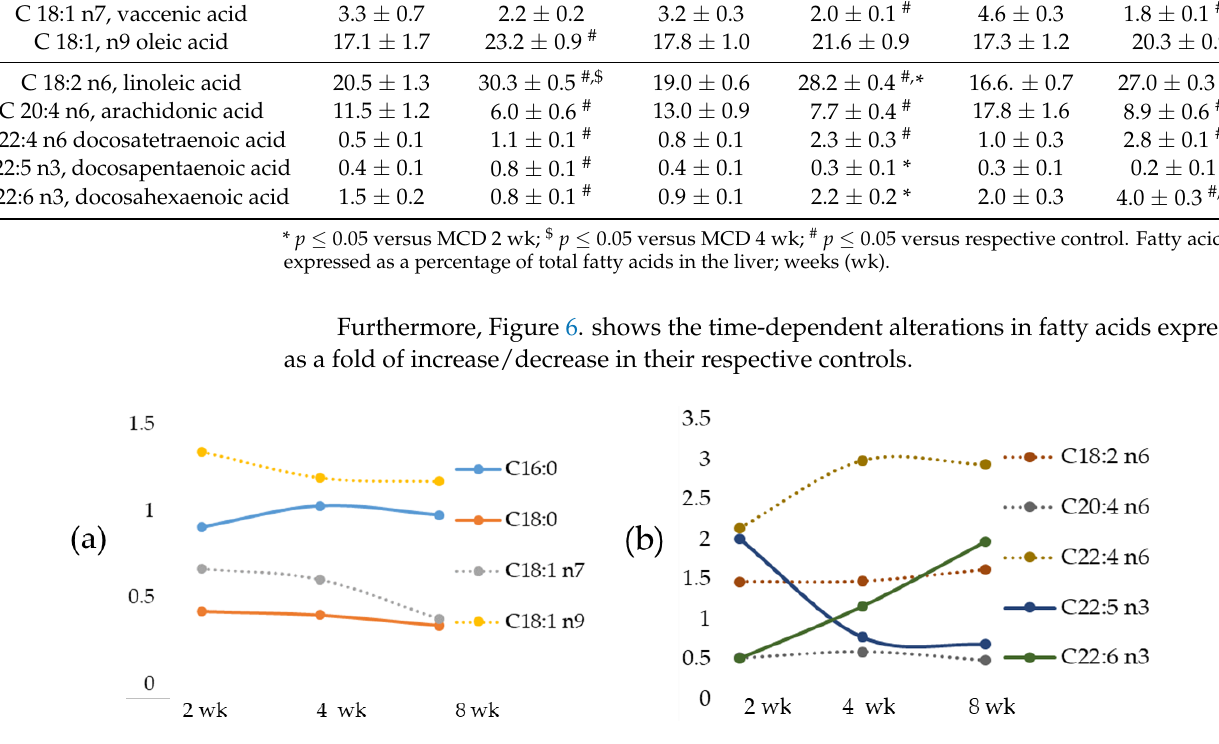
Figure 6. Time-dependent changes in liver fatty acids expressed as a fold increase/decrease in their respective controls. Tissue SFA and MUFA, panel ( a ); tissue PUFA panel ( b ). Weeks (wk). In MCD rats, a positive correlation was found comparing liver Zn versus stearic acid, vaccenic acid, arachidonic acid and docosapentaenoic acid (Table 8); on the contrary, an inverse correlation between linoleic acid and docosatetraenoic acid was reported (Table 8). Table 8. Correlation between liver Zn and Fe versus fatty acids.